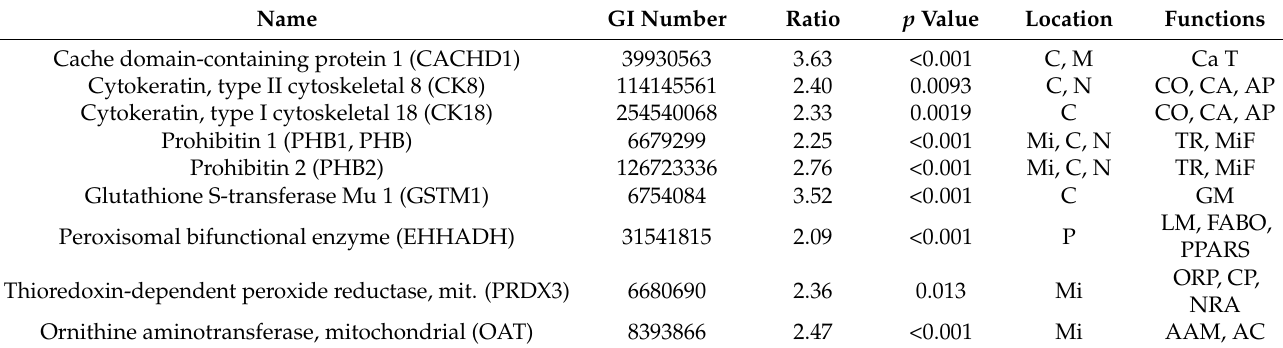
Table 2. Top-elevated proteins in HCCs of STAM mice identified by QSTAR Elite